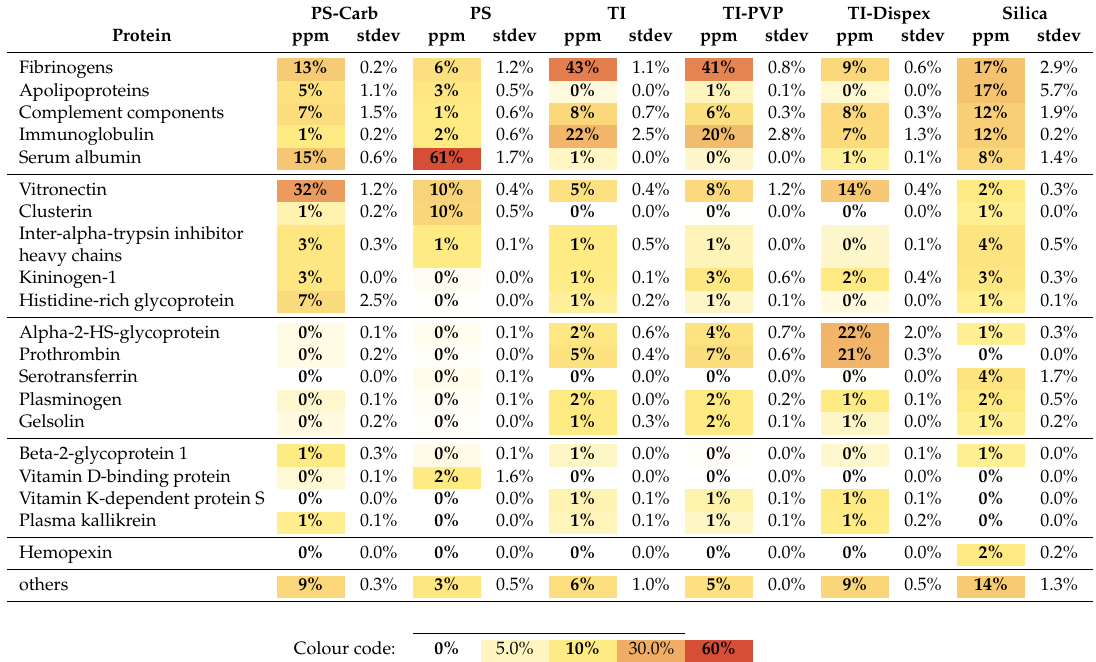
Table 3. Protein abundance of total protein content of the corona across all 6 NMs